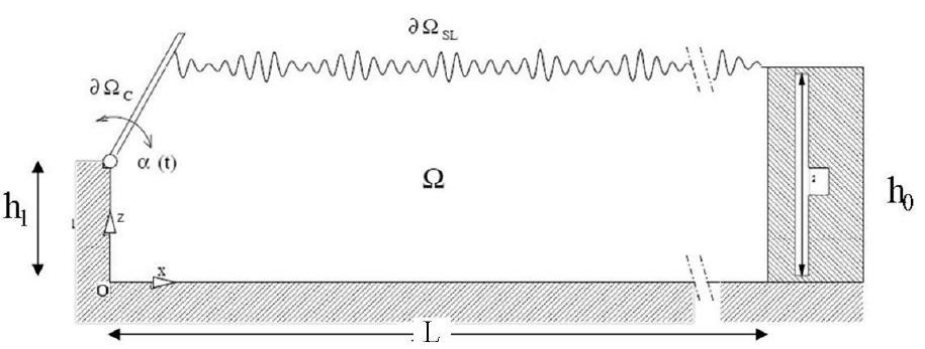
h = 3.6 m, h1 = 1.8 m, L = 230 0